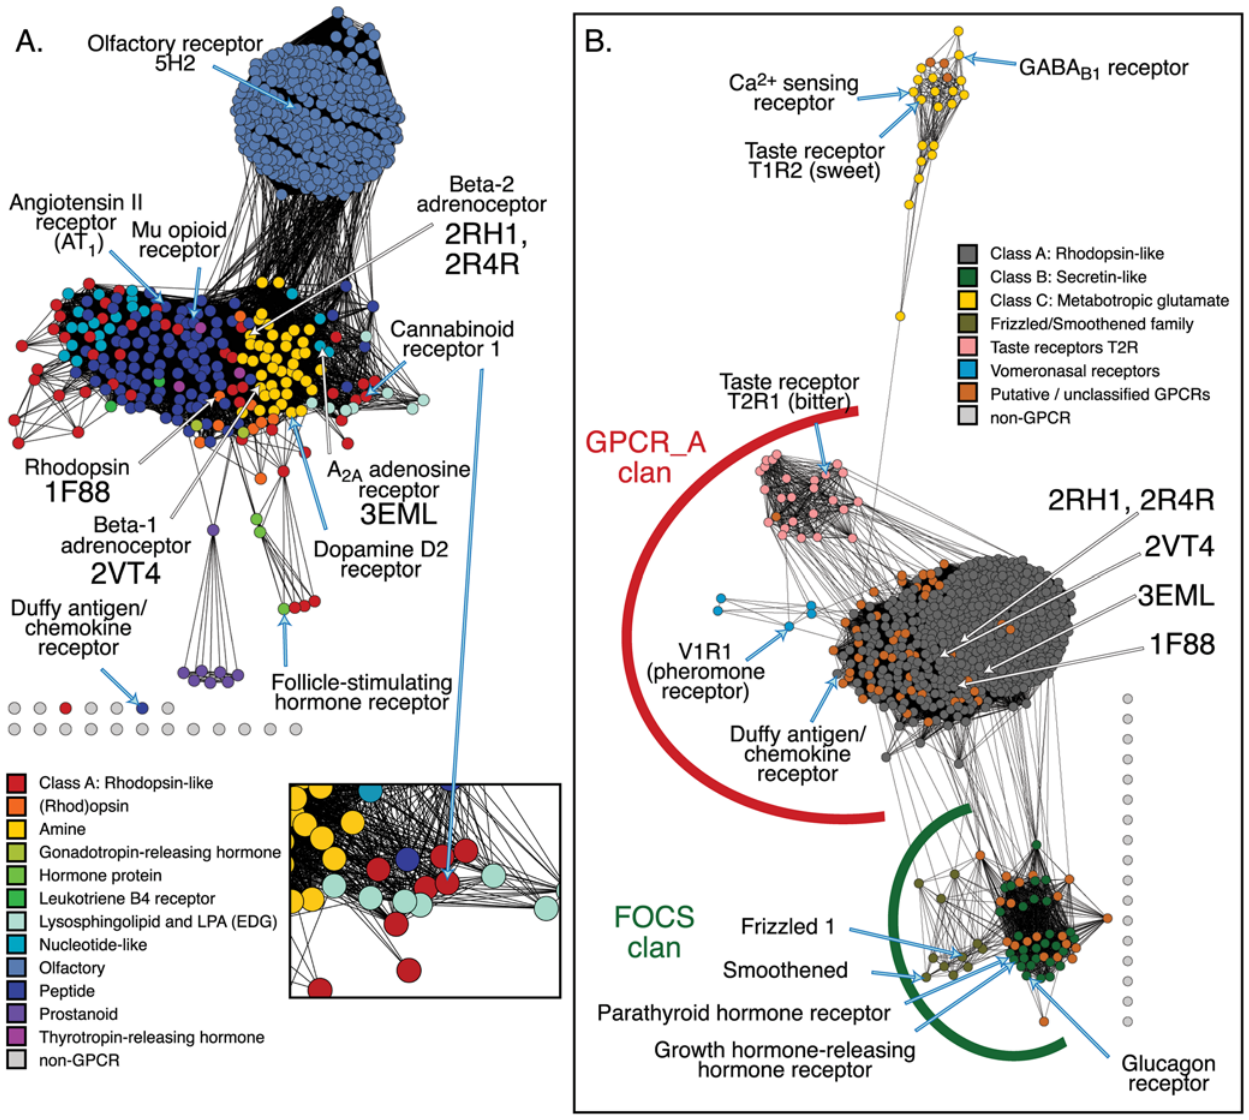
Figure 4. Visualizing very distant interrelationships between GPCRs. A. 605 human Class A: Rhodopsin-like GPCR domains. This sequence set includes the 42 amine-binding sequences from Table II and Fig. 2. This network was thresholded at a BLAST E-value of 1 6 10 2 11 ; the worst edges displayed correspond to a median of 24% identity over an alignment length of 210 amino acids. Sequences colored red for ‘‘Class A: Rhodopsin-like’’ were not classified to a specific subgroup within the class. B. 766 human GPCR domains. This sequence set includes all of the 605 Class A sequences from (A), now colored dark grey. This network was thresholded at an E-value of 1 6 10 2 2 , and the worst edges displayed correspond to a median of 22% identity over an alignment length of 120 amino acids. Also included in both networks is a set of 17 sequences in light grey. These sequences were used here as negative controls, and were randomly drawn from the human proteome and not annotated as GPCRs. The red and green clan labels correspond to PFAM clans[9]. The sequences that are associated with or that are extremely similar to high resolution structures are noted